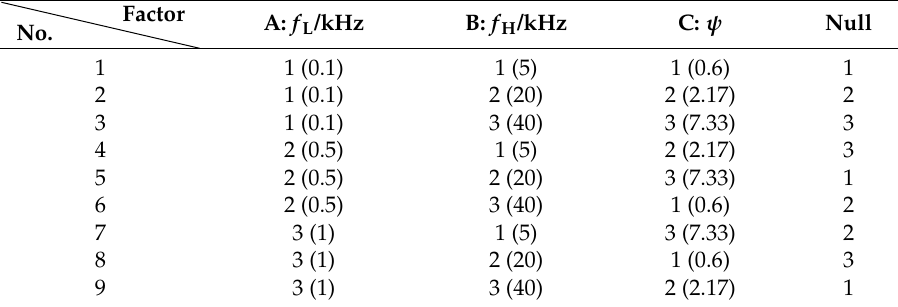
Table 3. L9(3 4 ) orthogonal experimental array.